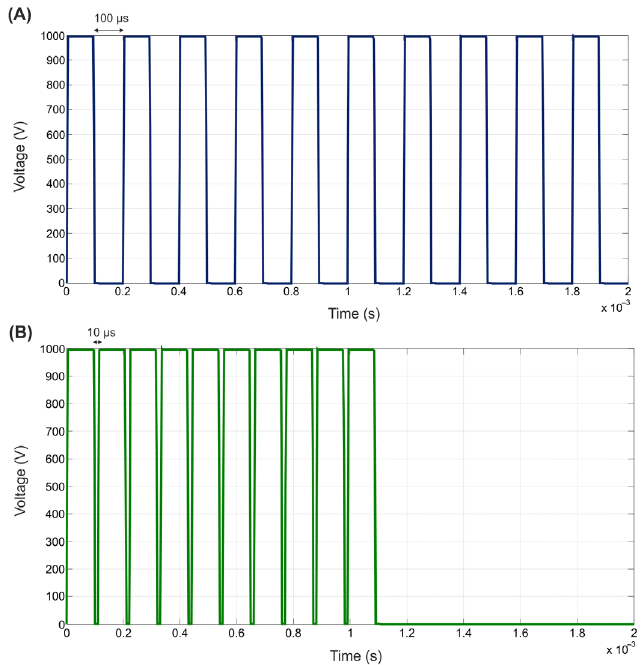
Figure 3. PEF pulse trains applied in the active electrode based on 10 consecutive pulses of 1000 V for 100 μs with an inter-pulse interval of 100 μs ( A ) and 10 μs ( B